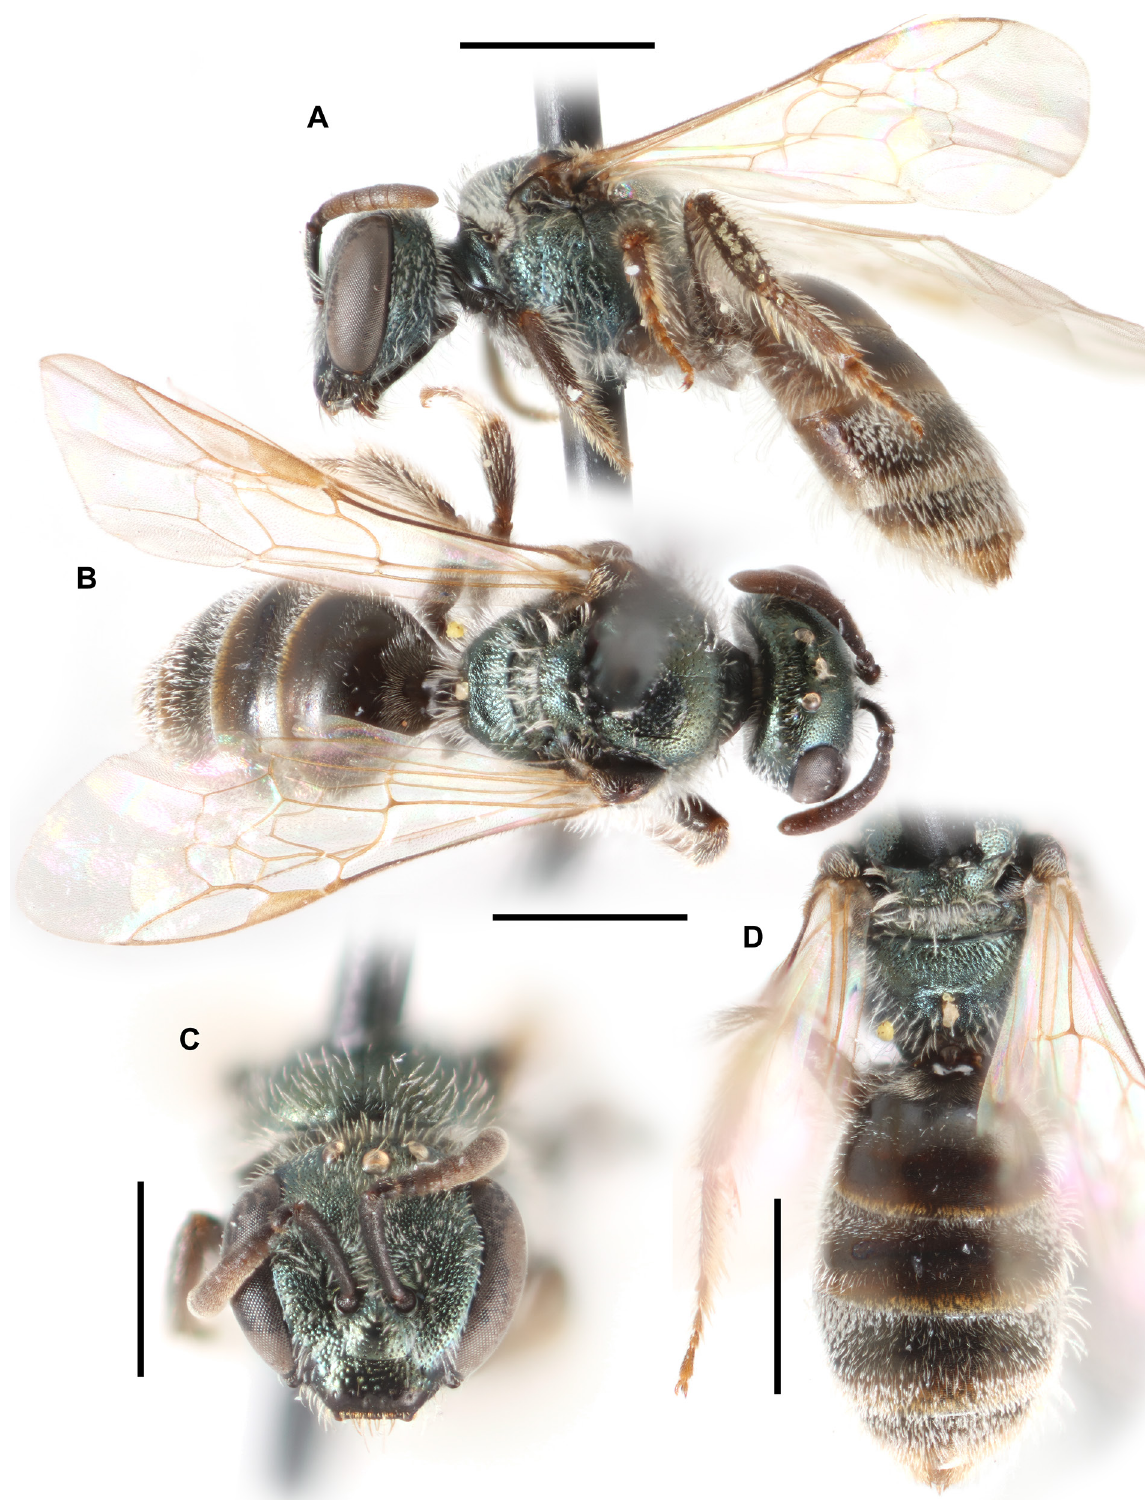
Fig. 61. Lasioglossum ( D .) stictaspis (Sandhouse, 1923), ♀, Colorado morph (reproduced from Gardner & Gibbs 2022) (UCMC). A . Lateral habitus. B . Dorsal habitus. C . Face. D . Metasoma and propodeum. Scale bars = 1